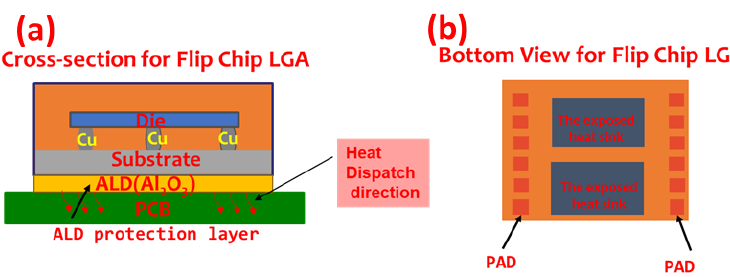
Figure 3. Cross section diagram illustrating the conditions of the ALD coating structure ( a ) and the bottom view of the flip-chip land grid array ( b ).